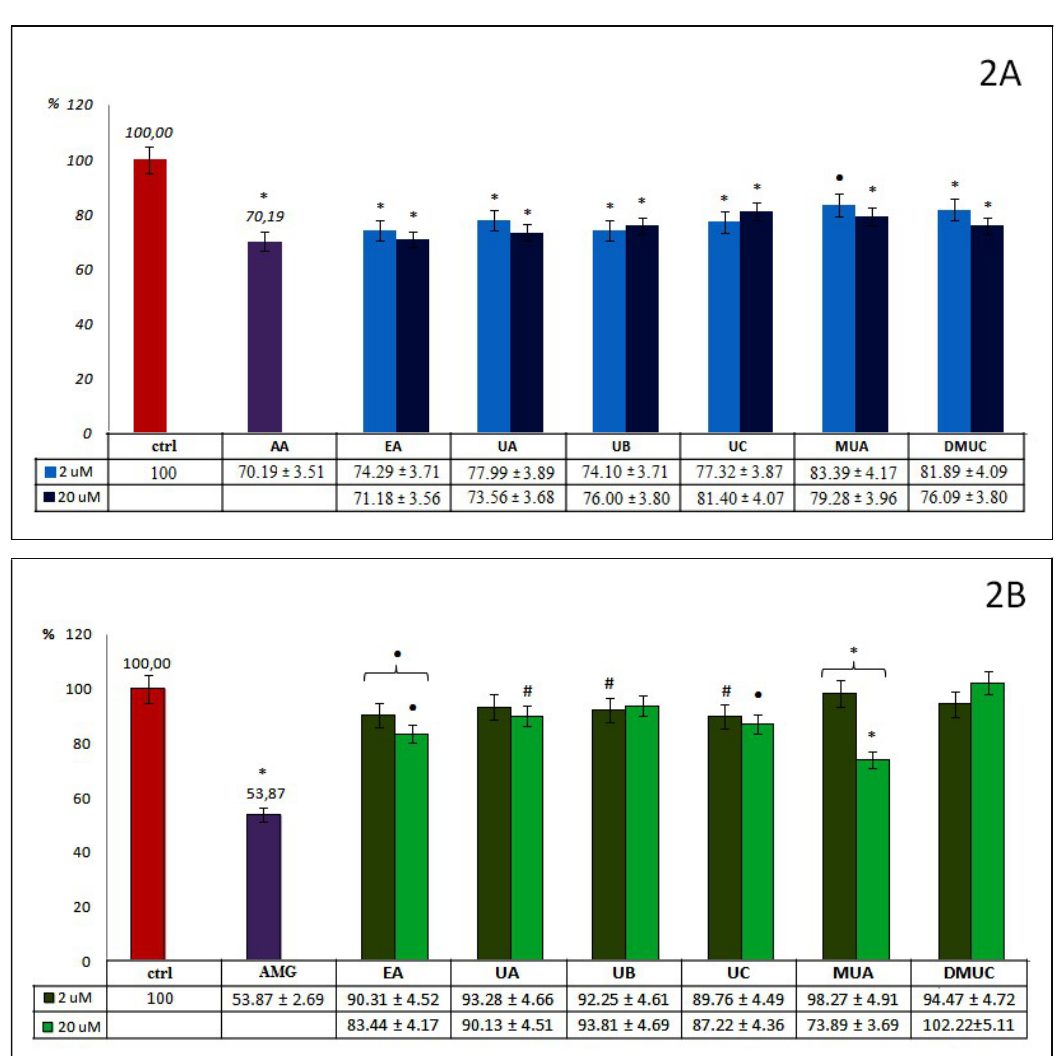
Figure 2. Percentage of AOPPs ( 2A ) and AGEs ( 2B ) formation during the glycoxidation process in samples incubated with 2 and 20 µM of tested ellagic acids and other ellagitannins metabolites (group 2.). Significant differences in comparison to (ctrl), as well as between both used concentrations were expressed as: (*) p < 0.001, (•) p < 0.01, (#) p < 0.05.